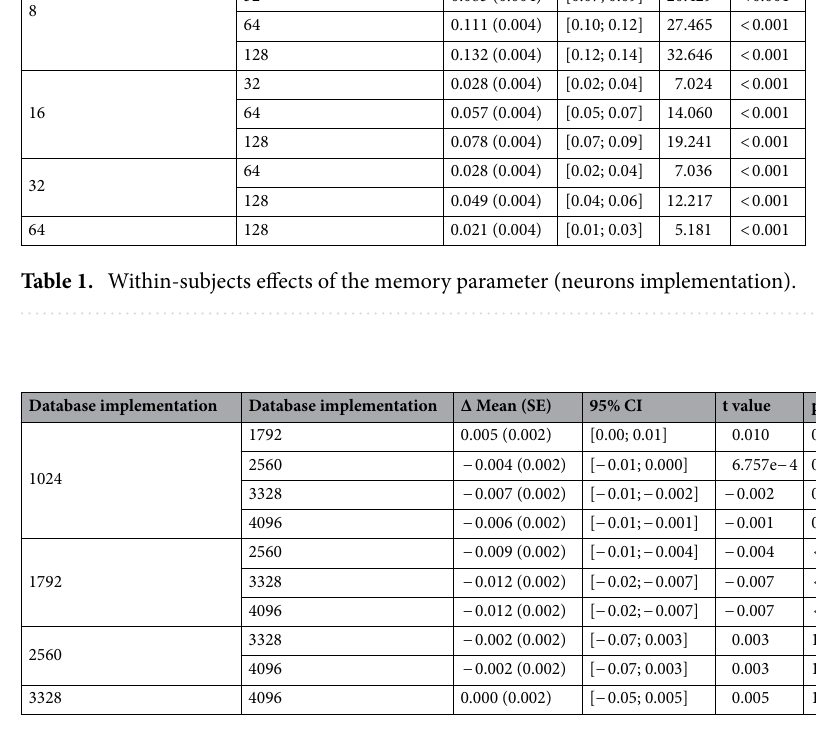
Table 2. Within-subjects effects of the attention parameter (database